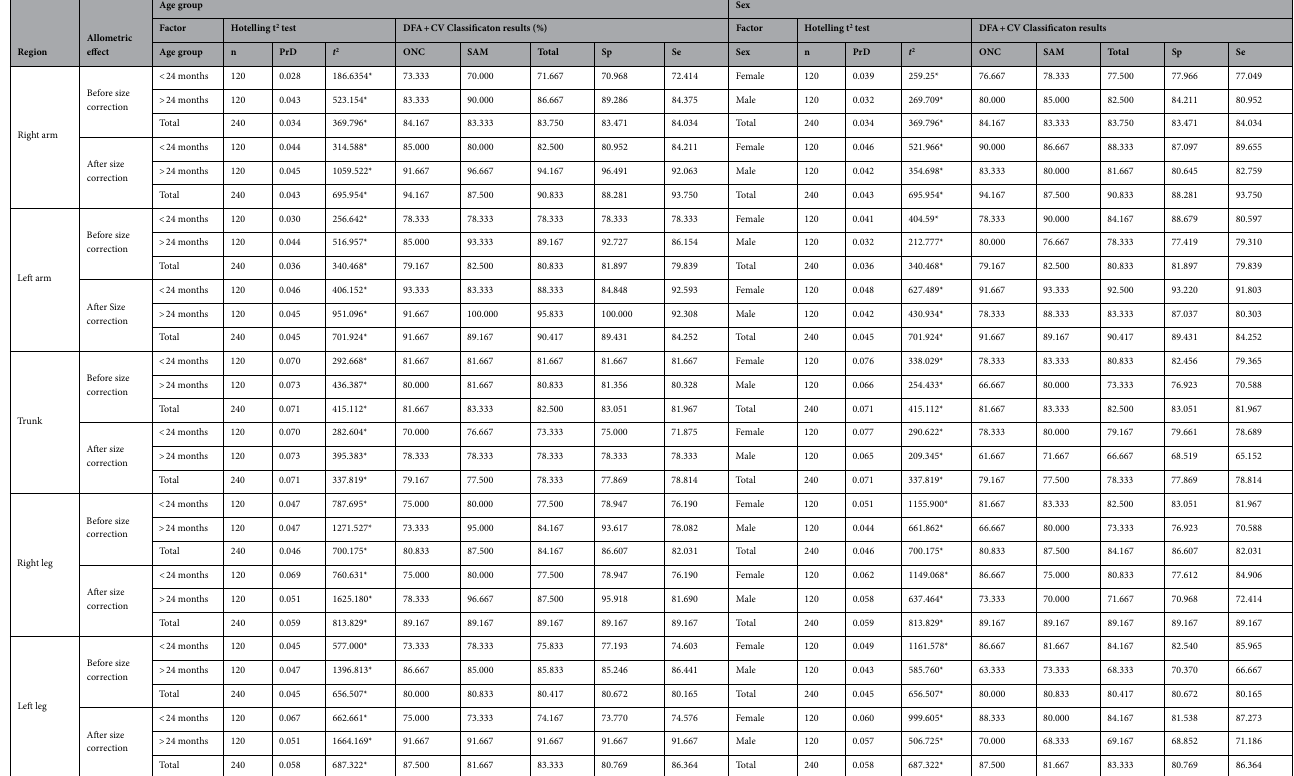
Table 3. Ontogenetic and sexual effect on nutritional status determination in body regions. Discriminant Function Analysis (DFA) cross-validated (CV) results for nutritional status determination in body regions